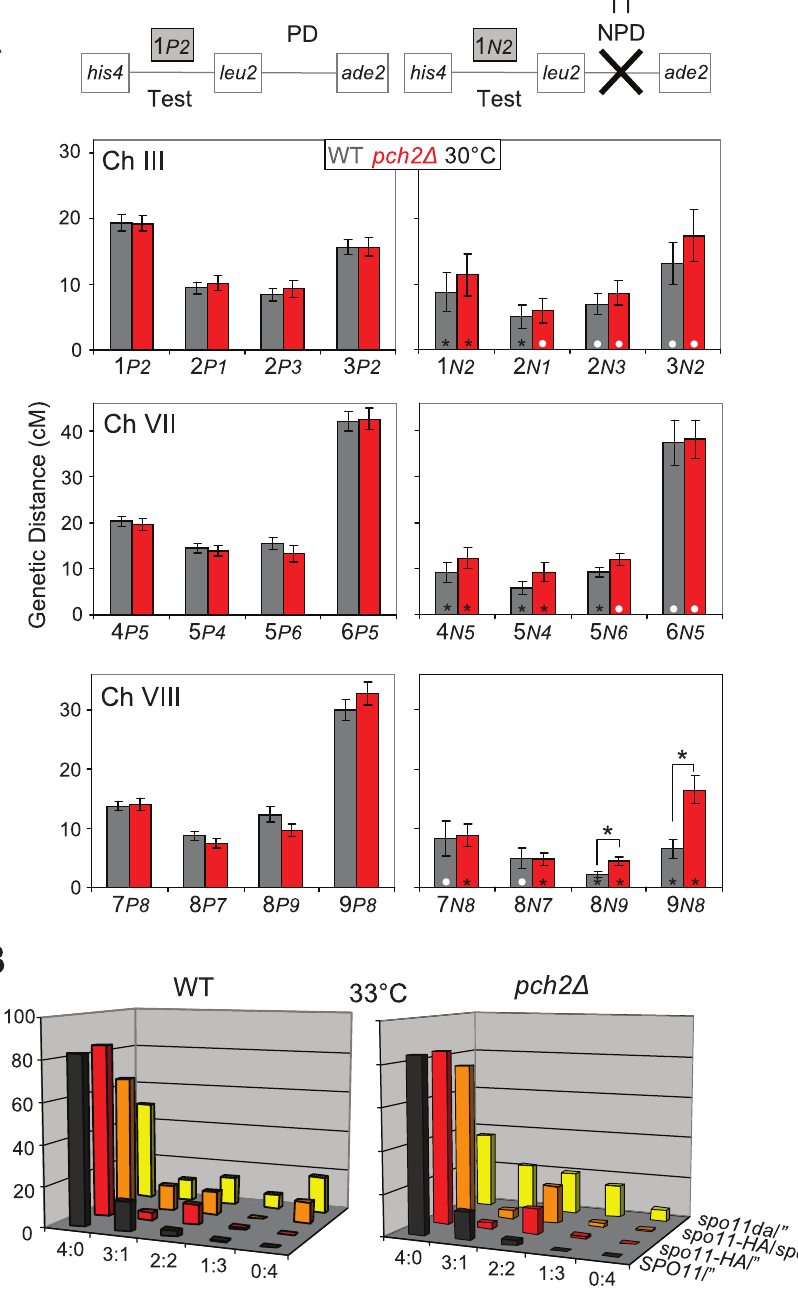
Figure 8. CO interference and spore viability in pch2 D and WT at different temperatures. (A) Modified coincidence analysis for the same strains shown in Figure 6, sporulated at 30 u C. Note that the apparent lack of interference between intervals 7 and 8 is likely due to large standard errors in the relatively smaller data set (see Table S1). See Figure 6 legend for details. (B) Spore viability patterns indicative of homolog nondisjunction for the same strains analyzed in Figure 7, sporulated at 33 u C. See Figure 7 legend for